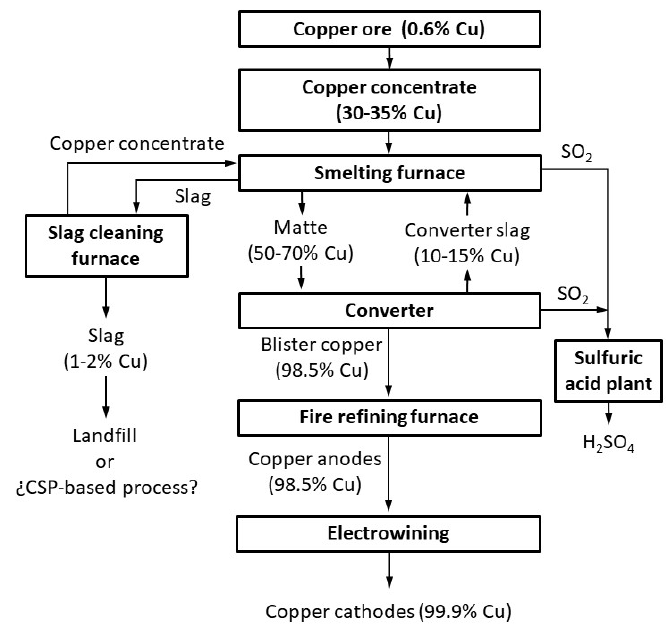
Figure 1. Flow diagram of the smelting conversion process of copper.